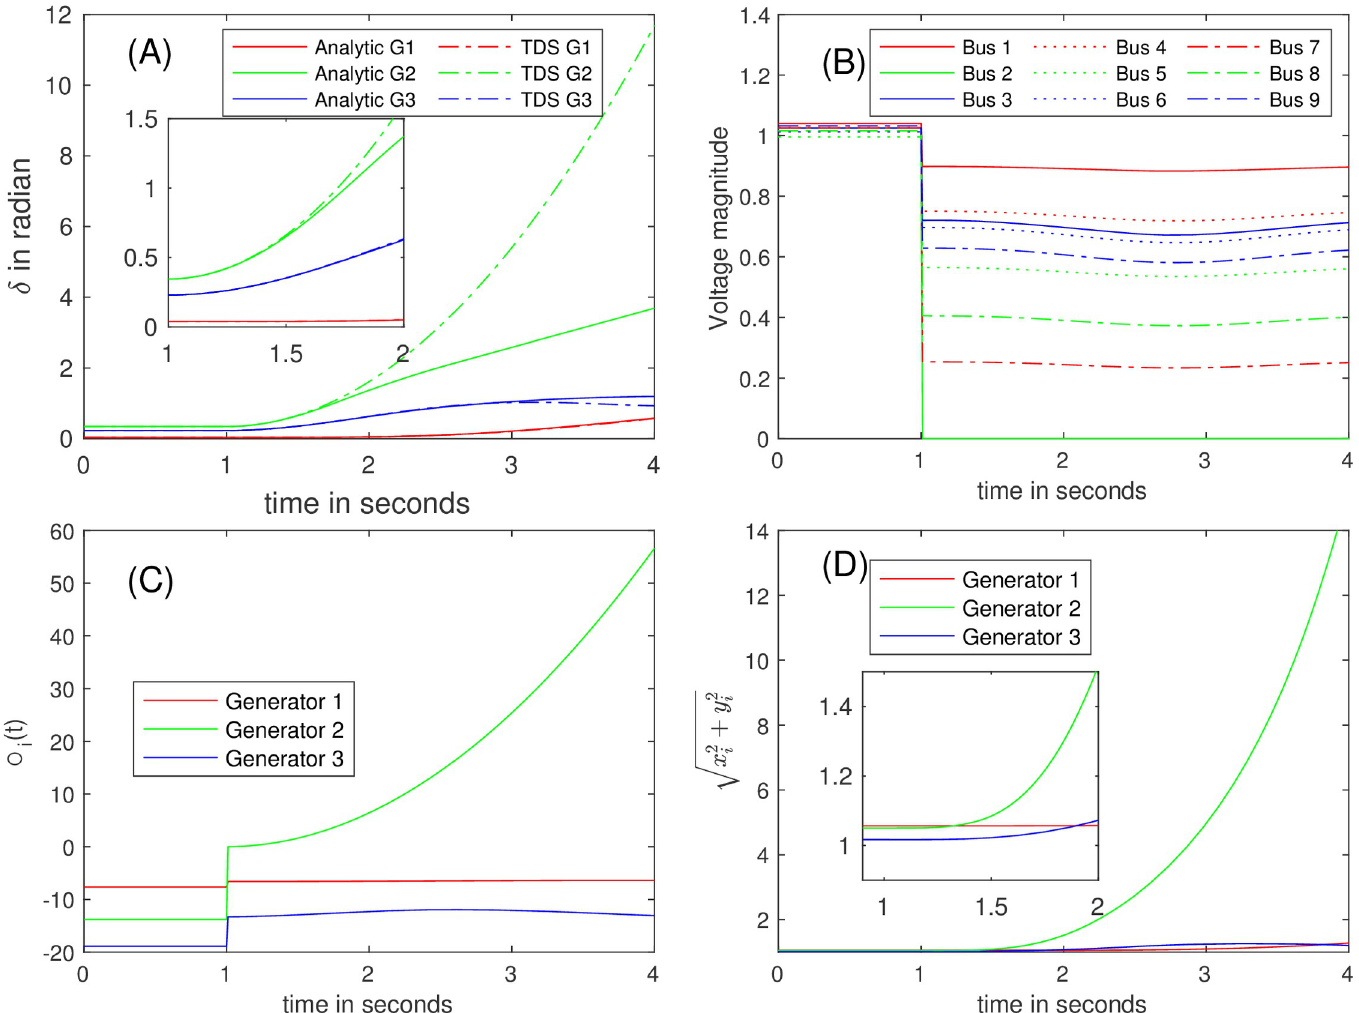
Fig 8. The trajectories of (A) δ , of (B) E , of (C) O i ( t ), and of (D) the estimated magnitudes of internal voltages due to the line fault at the line between Buses 7 and 8 near Bus 7 at t = 1 sec (red cross in Fig